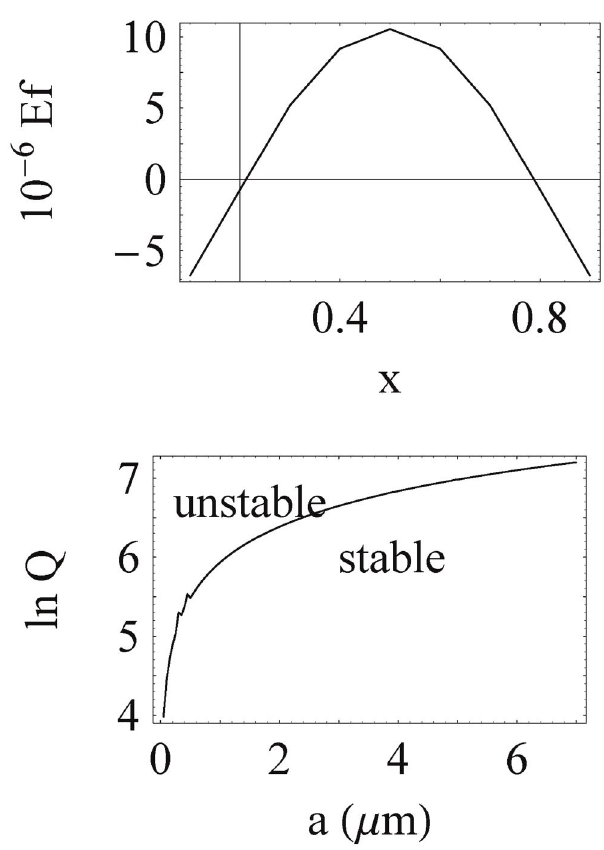
FIG. 3. Upper plot: energy released in fission to particles with the masses equal to the fraction x and 1 (cid:1) x of the initial mass calculated with Q (cid:8) 10 6 and the initial dust radius a (cid:8) 1 (cid:3) m . Bottom plot: the threshold charge Q as function of the radius a of the dust